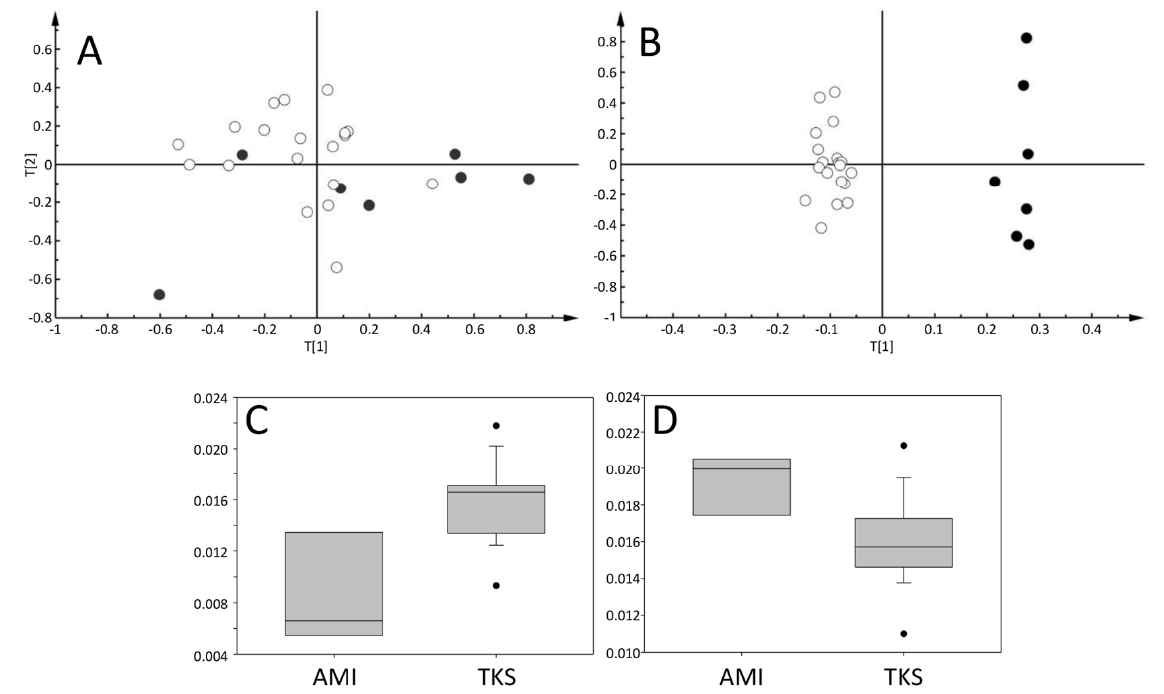
Figure 2. Pattern recognition analysis in the acute phase of TKS ( n = 19) (white circles), and AMI patients ( n = 8) (black dots). ( A ) corresponds to the score plot of the principal component analysis, showing a tendency towards classification. ( B ) is the score plot of the OPLS-DA of the same samples. ( C , D ) correspond to box plots for acetate (1.93 ppm) and methylene lipid peaks (1.28 ppm), respectively, which were identified as being responsible for the differences in the OPLS-DA